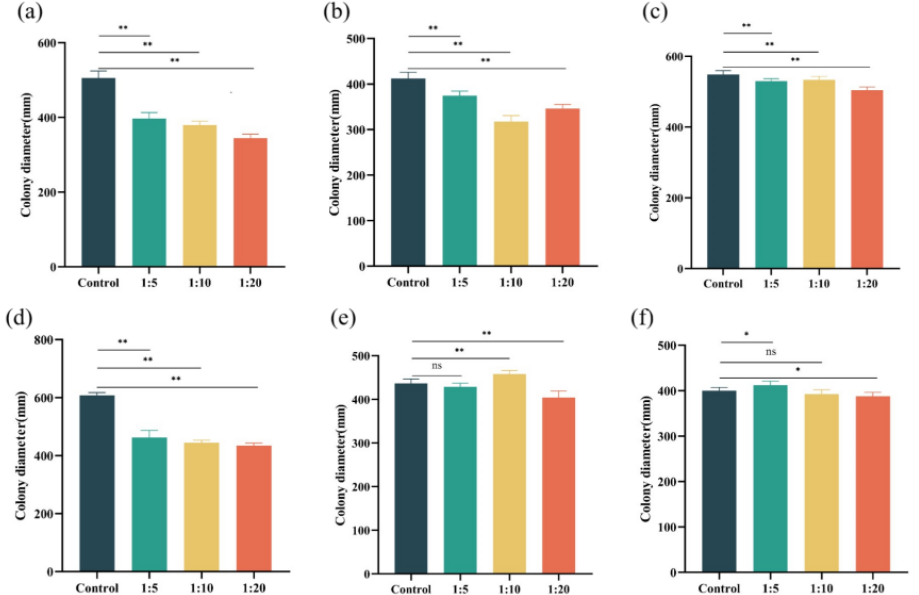
Figure 5. Analysis of the difference of colony diameters of pathogenic fungi affected by bacterial BsNLG8 aseptic filtrate. The aseptic filtrate of bacterial BsNLG8 was prepared into a culture medium according to the ratio of 1:5, 1:10 and 1:20, and then inoculated with six types of pathogenic fungi, the statistical differences in colony diameters were analyzed. ( a ) F. oxysporume , ( b ) S. curtisii , ( c ) B. dothidea ( d ) C. higginsianum , ( e ) G. candidum and ( f ) M. oryzae . “*” and “**” showed significant differences at p < 0.05 and p < 0.01, and “ns” represents non-significant differences.